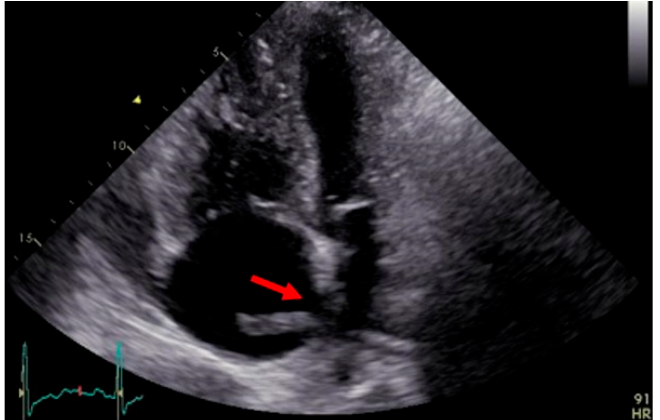
Figure 4. Transthoracic echocardiography showing the thrombus through the foramen ovale (red arrow).